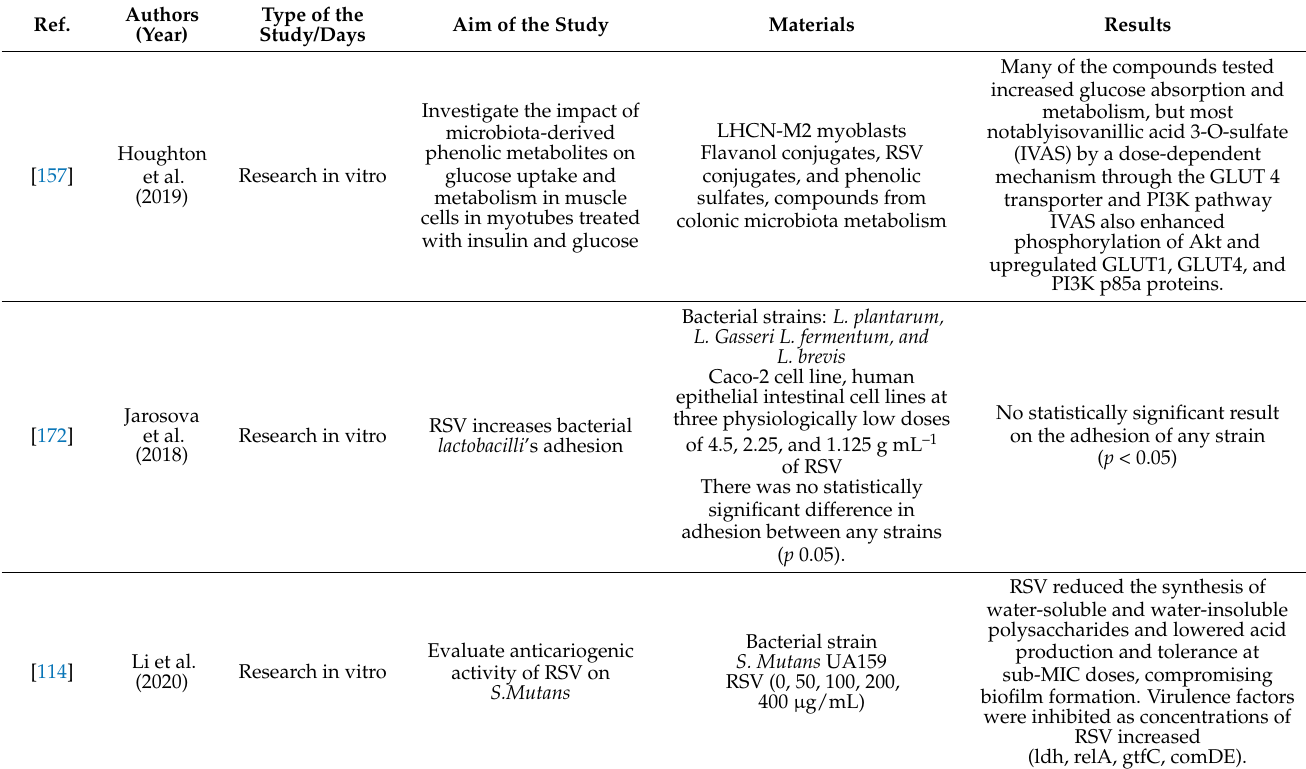
Table 3. Effects of RSV and phenolic compounds on glucose uptake and metabolism in muscle cells, Lactobacillus adherence to intestinal epithelial cells, and S.Mutans cariogenic